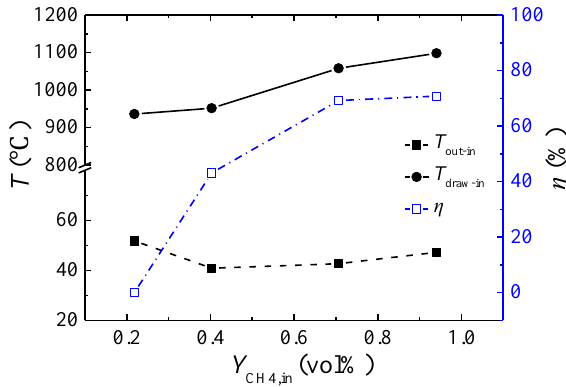
Figure 13. Temperature difference between the hot gas withdrawal flow and inlet gas ( T draw-in ), outlet-inlet gas temperature difference ( T out-in ), and heat recovery efficiency ( η ) for different feed methane concentrations ( Y CH4,in ) at F in ≈ 105 × 10 3 Nm 3 /h and t c = 300 s.